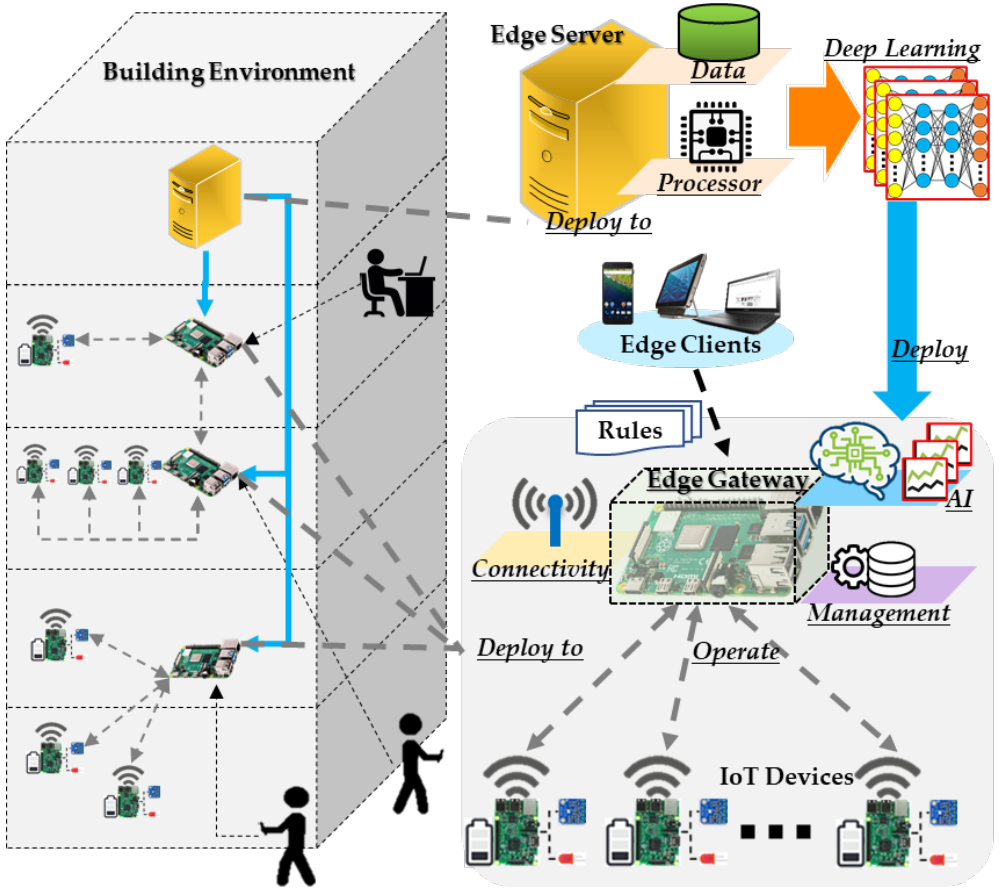
Figure 1. Proposed intelligent edge computing for building environment control.